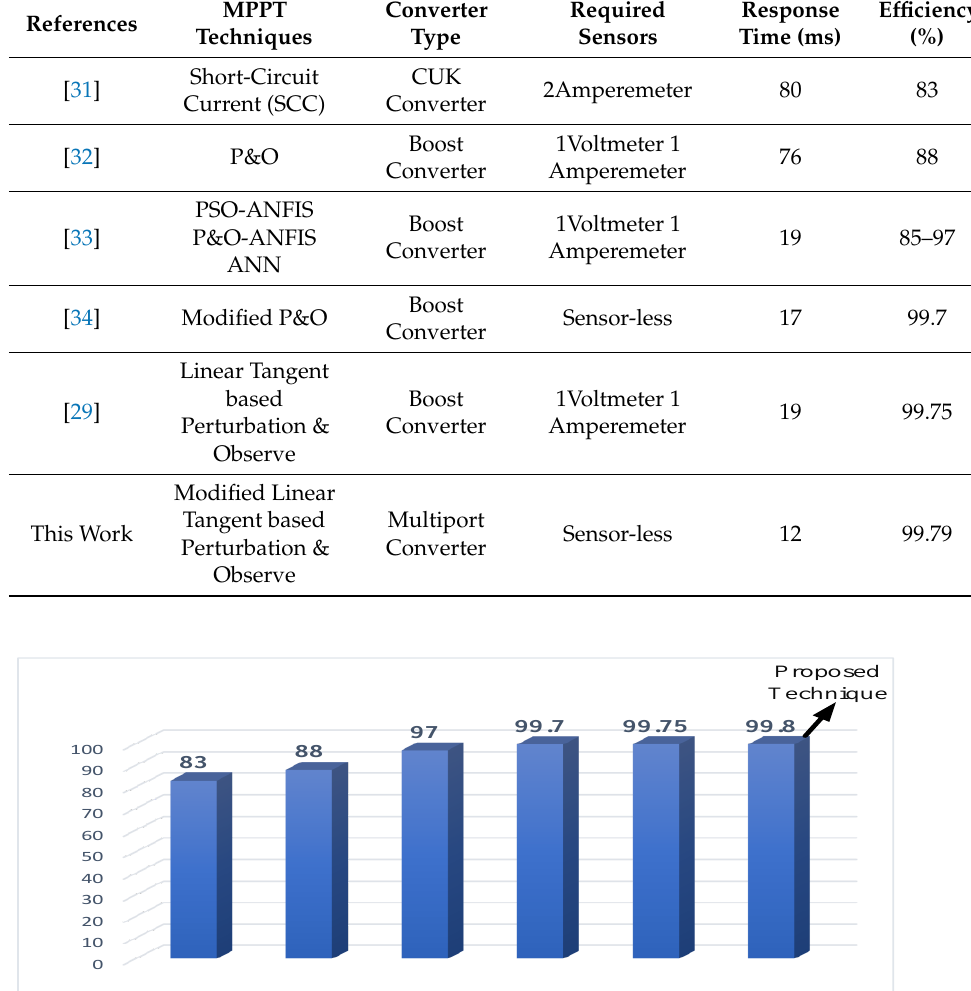
Figure 25. Efficiency comparison of different MPPT with converter models.